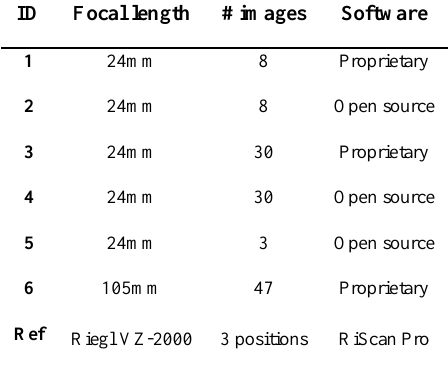
Table 1. Investigated configuration parameters for the data acquisition phase.